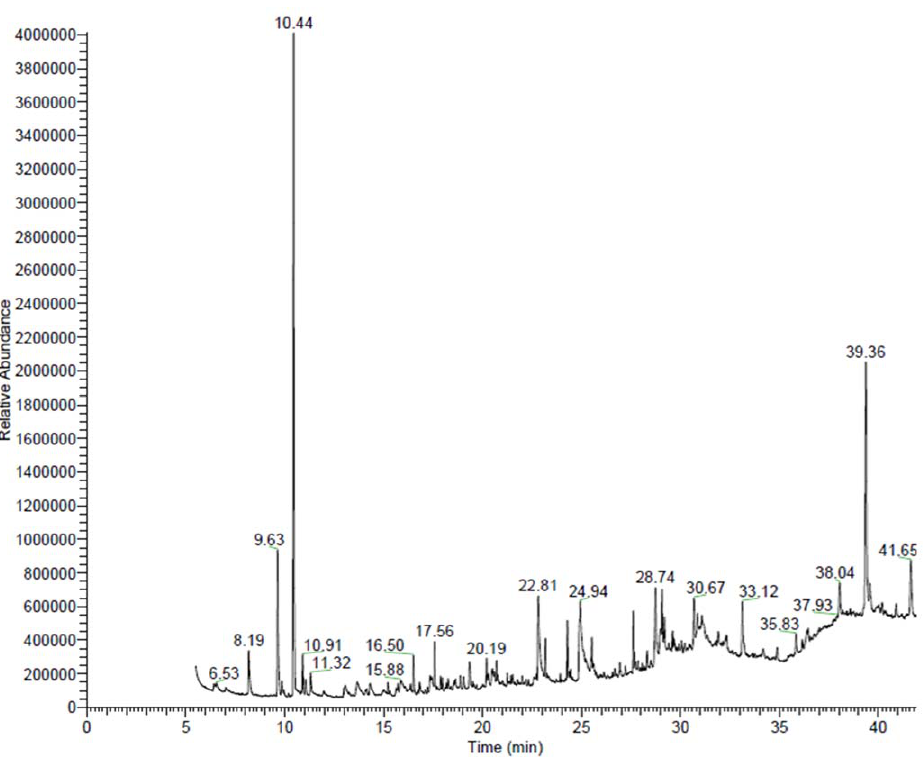
Figure 3. GC/MS chromatogram of dichloroethane root extract of R.imbricata .